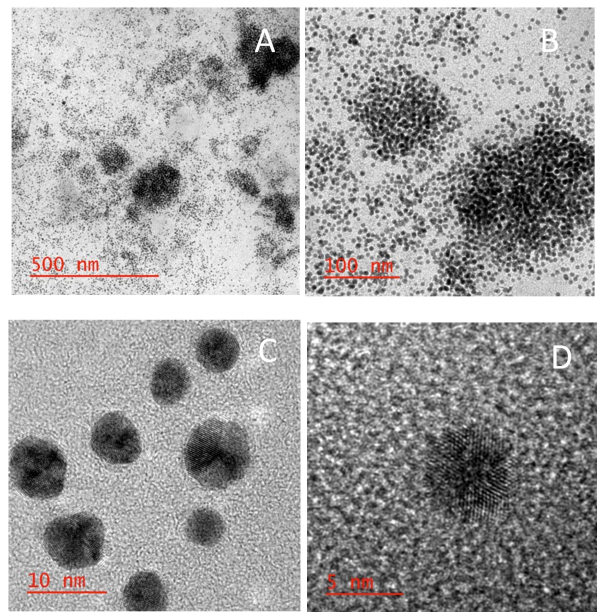
Figure 1. High resolution transmission electron microscopy (HRTEM) images of small, monodispersed Fe 3 O 4 nanoparticles (NPs) as contrast agents in diphenyl ether observed under di ff erent